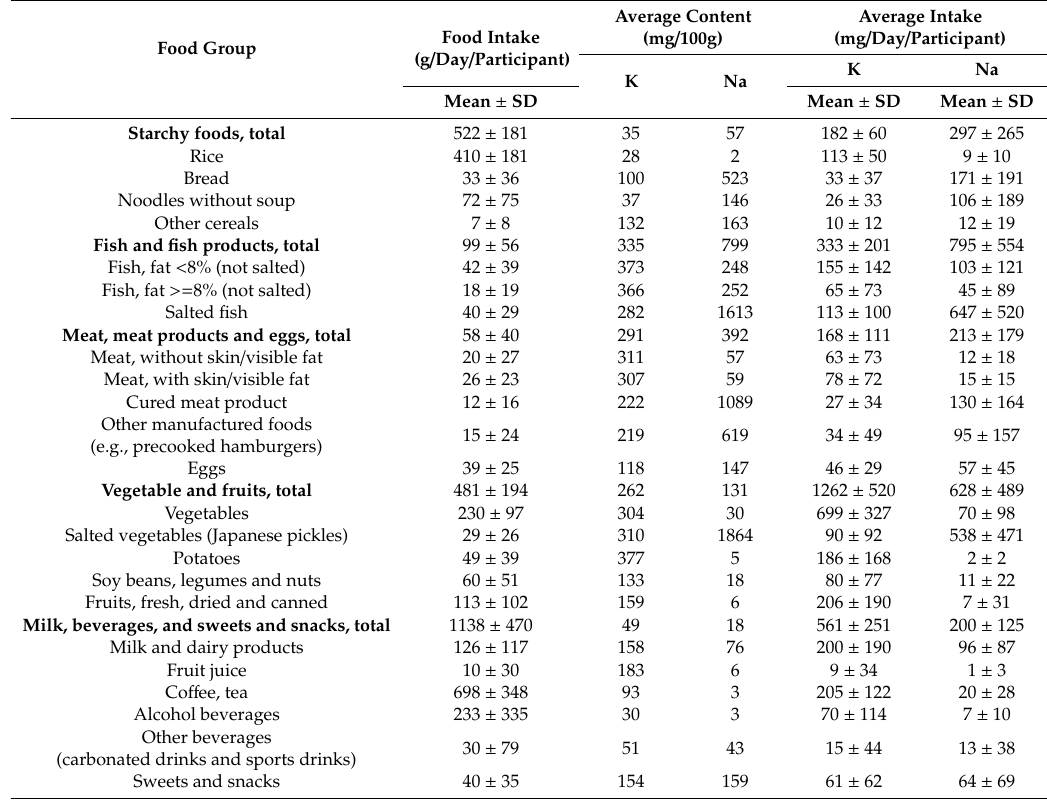
Table 1. Twenty-nine food categories for investigation of the association of food group consumption with potassium (K)